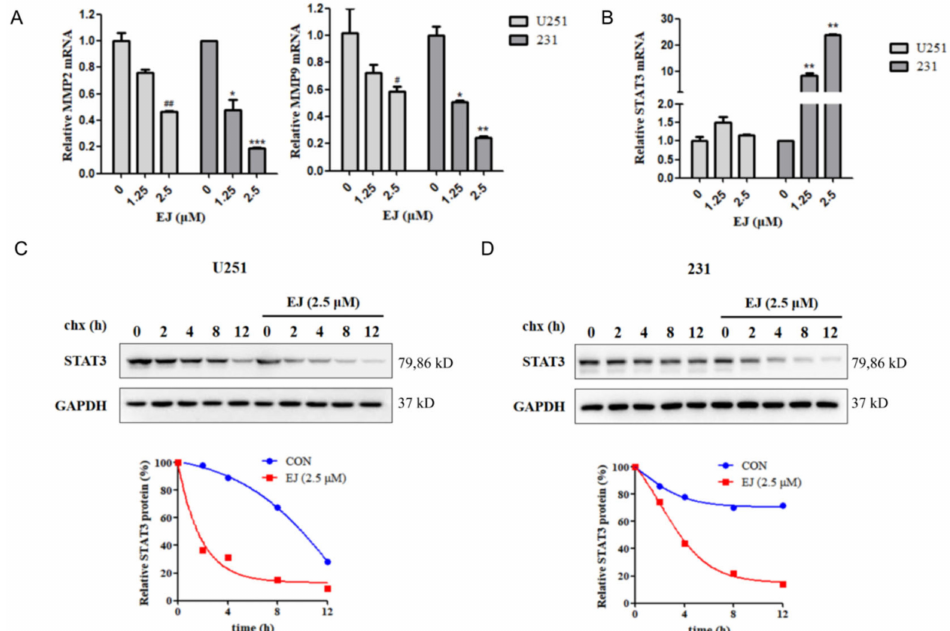
Figure 5. EJ promoted the degradation of STAT3 protein. ( A ) EJ dose-dependently downregulates MMP-2 and MMP-9 mRNA levels in cancer cells. ( B ) Effect of EJ on the expression of the STAT3 mRNA in cancer cells. EJ had no significant effect on the STAT3 mRNA in U251 cells, but upregulated the expression of the STAT3 mRNA in MDA-MB-231 cells. ( # vs. U251 control: # p < 0.05, ## p < 0.01. * vs. 231 control: * p < 0.05, ** p < 0.01, *** p < 0.001). ( C , D ) EJ reduced the half-life of the STAT3 protein in U251 ( C ) and MDA-MB-231 ( D ) cells, as shown by CHX chase